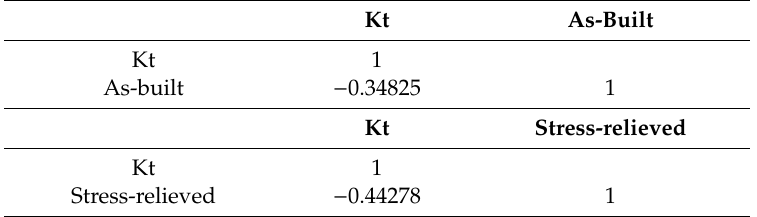
Table A10. Kt—Rm correlation for the two populations (discriminated by the specimen